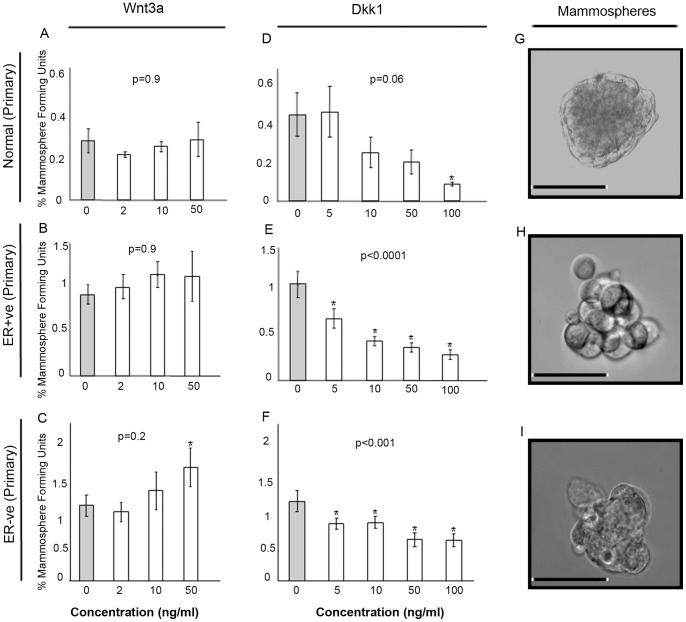
Modulation of Wnt signalling in normal and primary breast cancer samples (Normal n = 3; ER+ve n = 3; ER-ve n = 3).Single cells were plated in non-adherent conditions and treated with increasing concentrations of either Wnt3a (0–50 ng/ml) or DKK1 (0–100 ng/ml) and cultured for 7 days and number of mammospheres counted. Wnt3a treatments are displayed in the left panel and DKK1 treatments in the right panel. Light grey bars represent untreated control A) primary normal breast cells (Wnt3a) B) ER+ve primary breast cancer cells (Wnt3a) C) ER-ve primary breast cancer cells (Wnt3a) D) primary normal breast cells (DKK1) E) ER+ve primary breast cancer cells (DKK1) F) ER−ve primary breast cancer cells (DKK1). Data is expressed as % mammosphere formation units. P values were generated by ANOVA. Asterisks mark individual comparisons which reached statistical significance * >0.01 ** >0.001 generated by a T-test. G) Image of a normal primary mammosphere H) Image of an ER positive primary tumour mammosphere I) Image of an ER negative primary tumour mammosphere. Scale bar represents 50 µM.